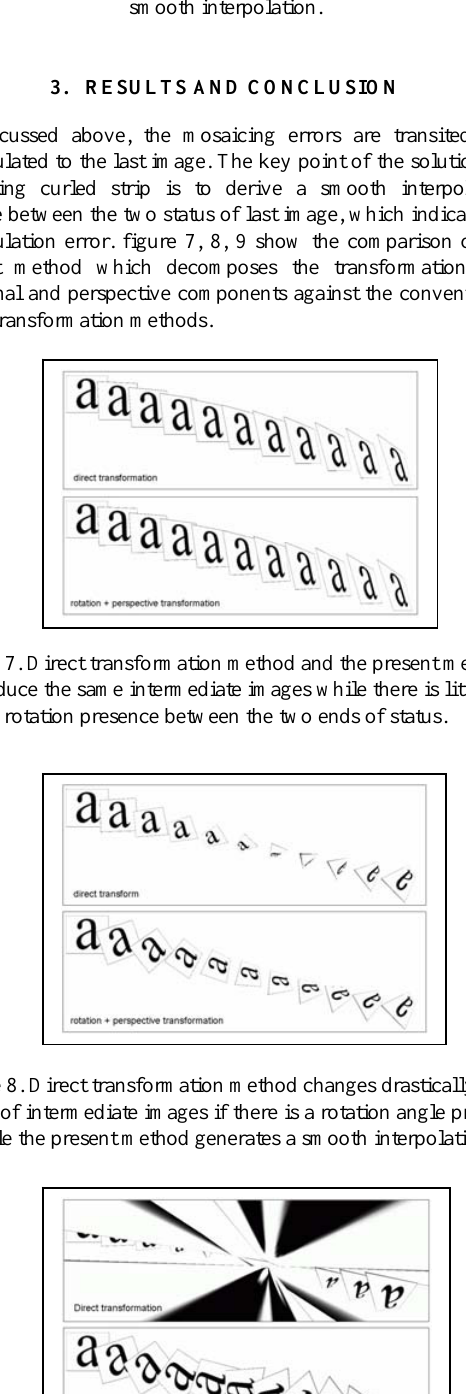
smooth interpolation.